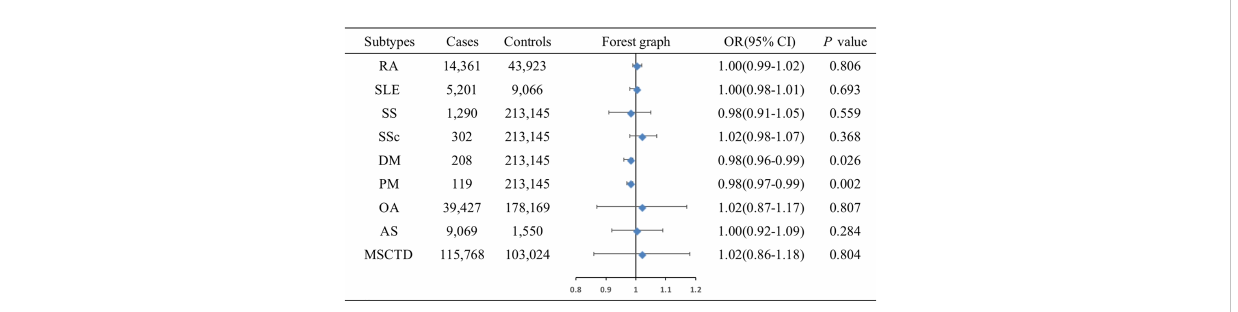
FIGURE 3 Associations of genetic liability to MSCTD with risk of ER+ BC in the European individuals. AS, ankylosing spondylitis; BC, breast cancer; CI, con fi dence interval; ER, estrogen receptor, DM, dermatomyositis; MSCTD, diseases of the musculoskeletal system and connective tissue; OA, osteoarthritis; OR, odds ratio; PM, polymyositis; RA, rheumatoid arthritis; SLE, systemic lupus erythematosus; SSc, systemic sclerosis; SS, Sjogren